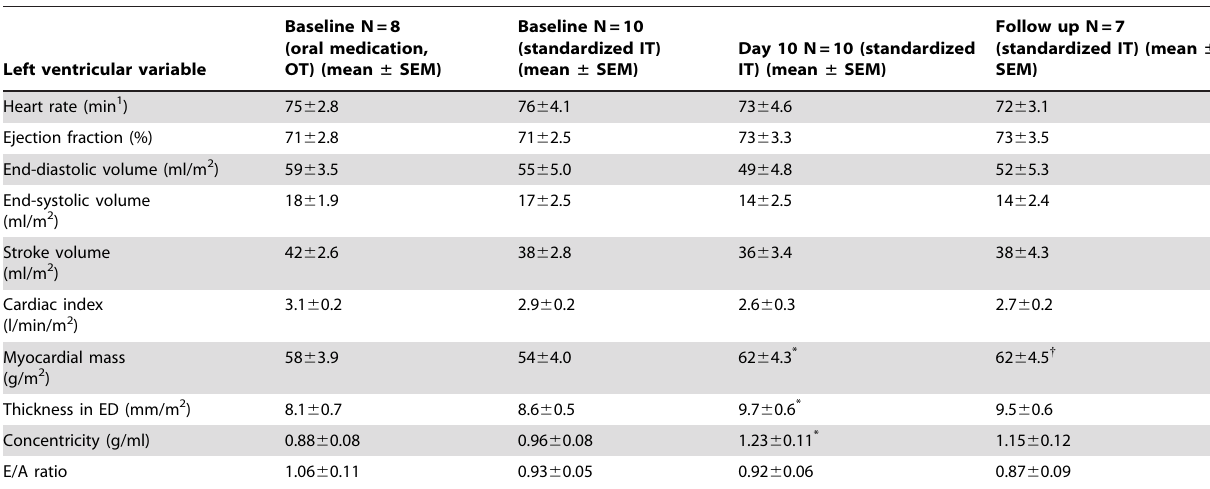
Table 2. Results of MR imaging studies.